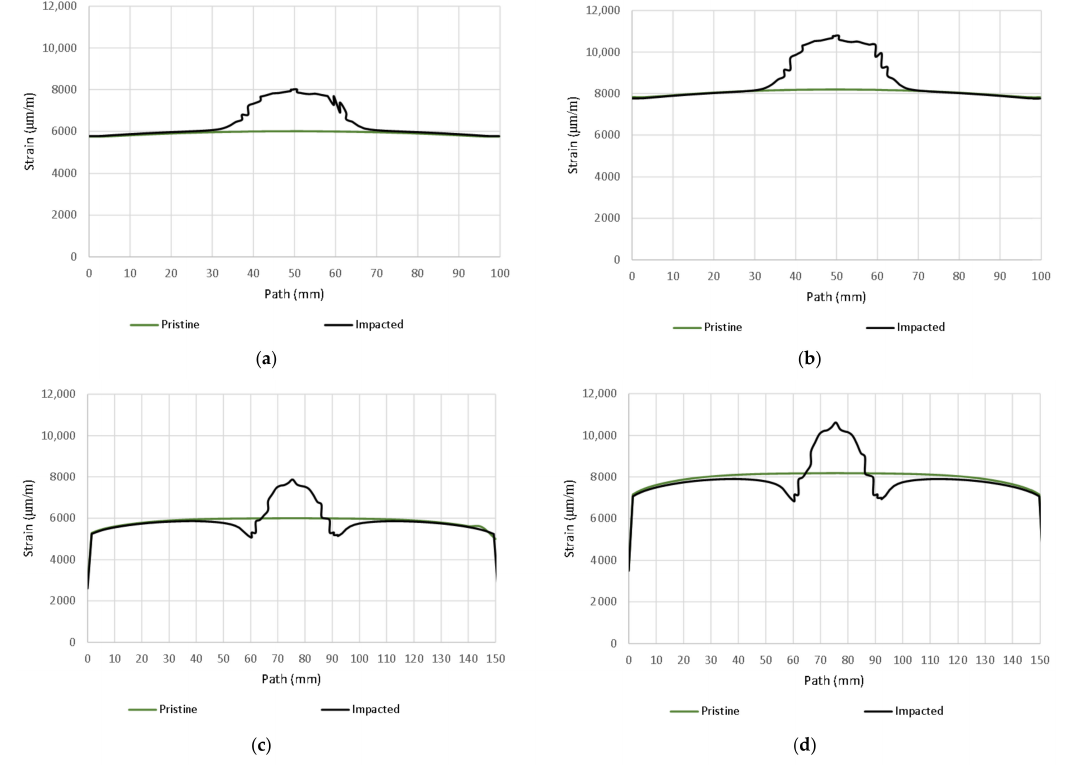
Figure 20. Comparison of max. principal strain distribution ( µ m/m); ( a ) Horizontal path at load 80